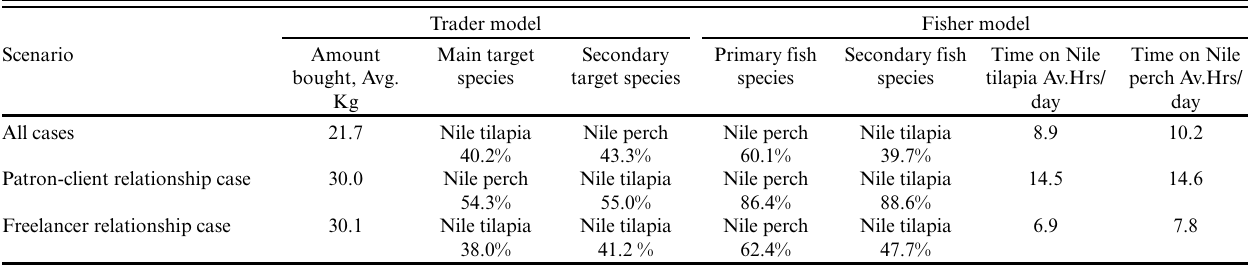
Table 4 . The key output results of the scenarios listed in table 3 from the Bayesian Belief